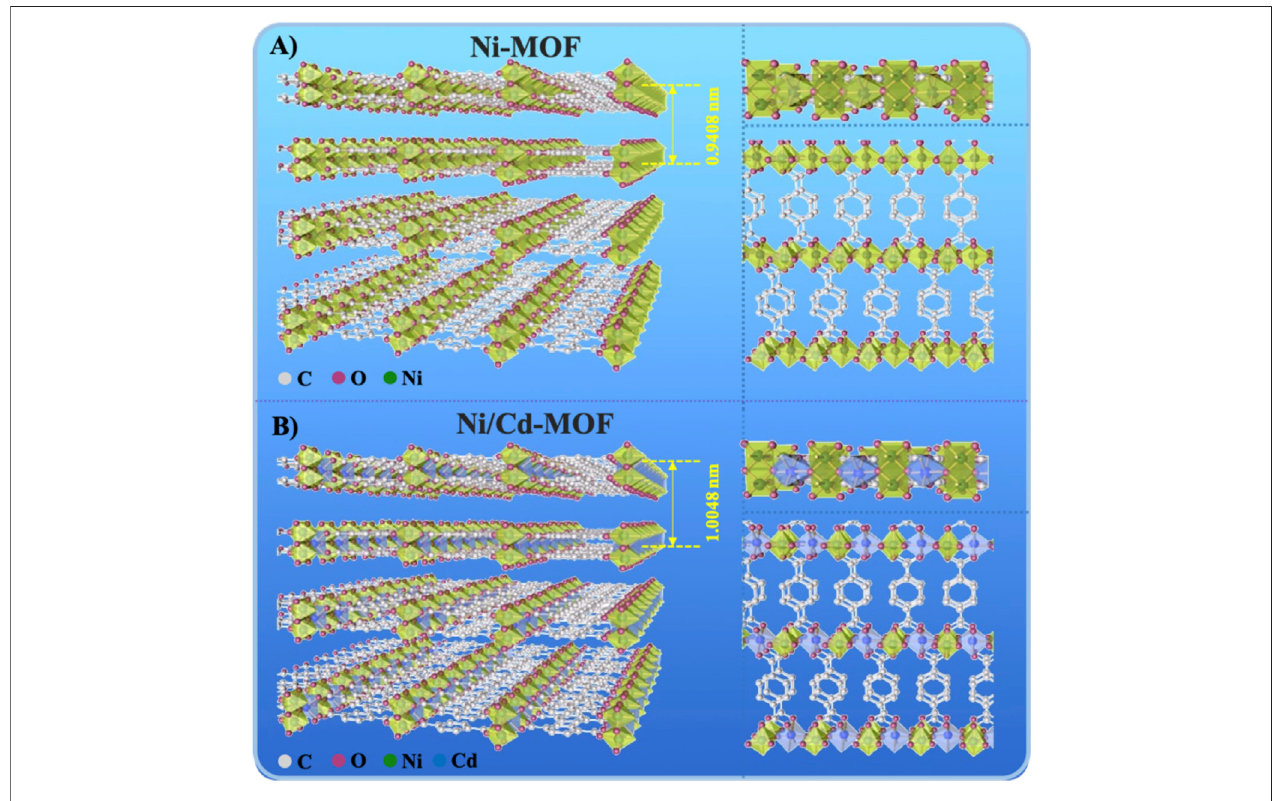
FIGURE 3 | Structure schematic diagram of (A) Ni-MOF and (B) Ni/Cd-MOF.